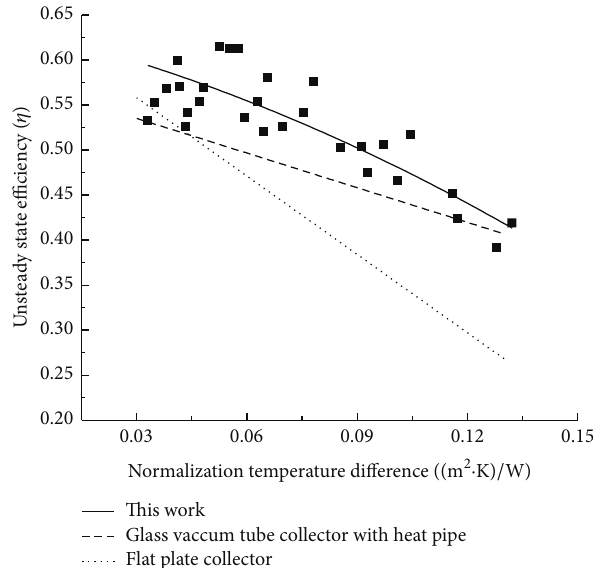
Figure 11: Unsteady-state efficiency curves for three types of solar collectors.